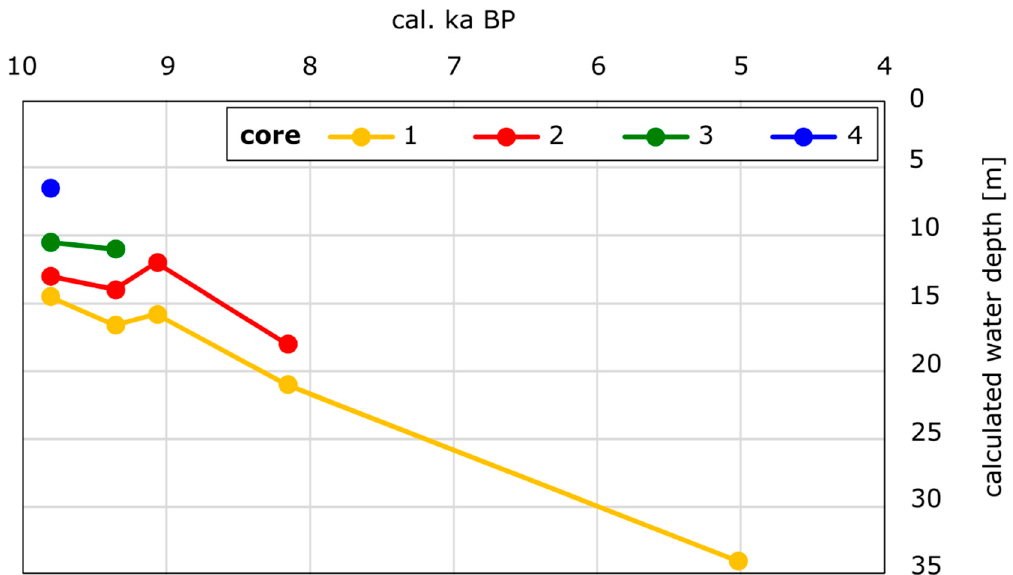
Figure 13. Calculated water depth (using the PEV curve of Vink et al. [20] in Figure 12) for the seismic reflectors with age determination.